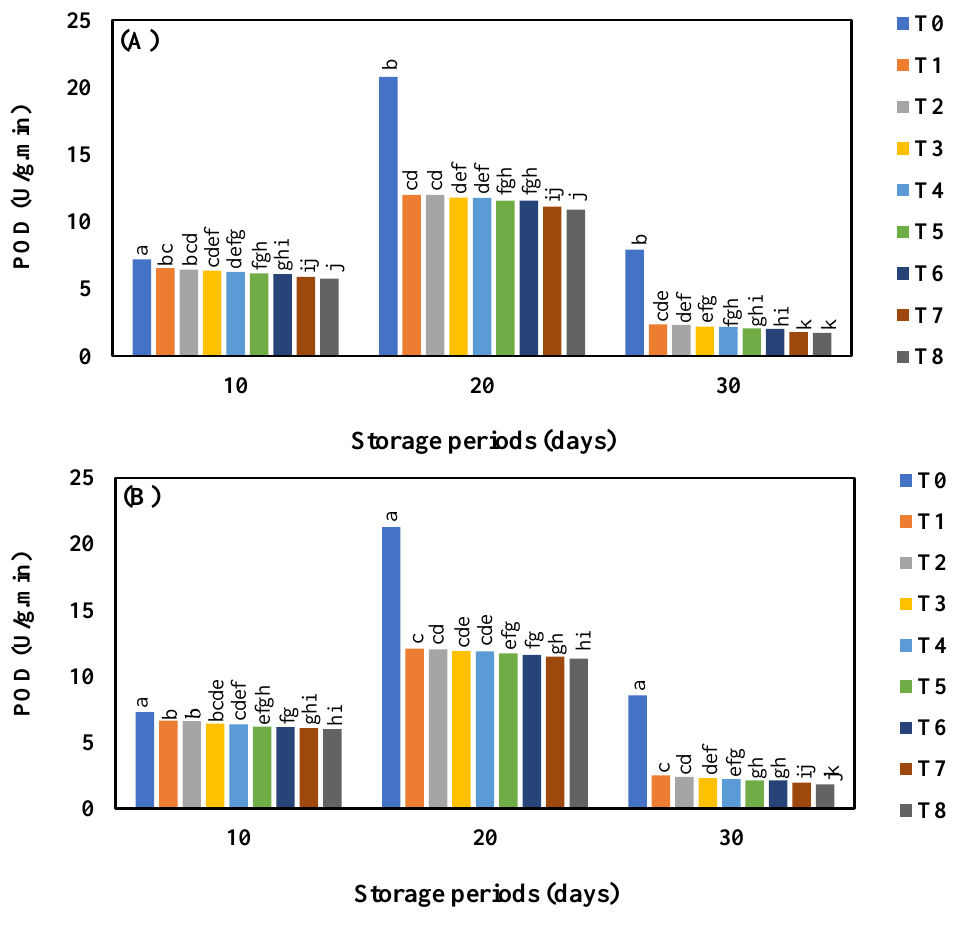
Figure 7. Effect of AgNO 3 and Ag-NPs on Pyrogallol peroxidase (POD) activity in Shine Muscat ( A ) and Kyoho ( B ) of grape varieties during 30 days cold storage.